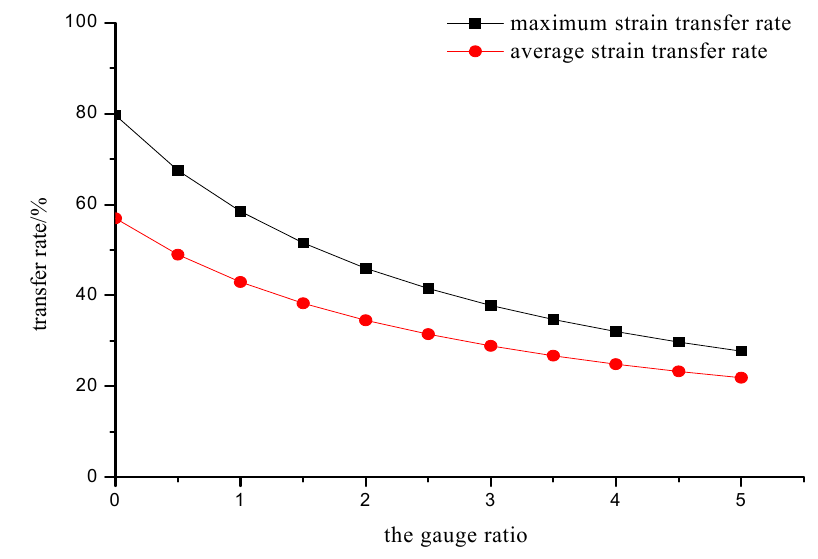
Figure 5. Gauge ratio-FBG strain transfer rate.